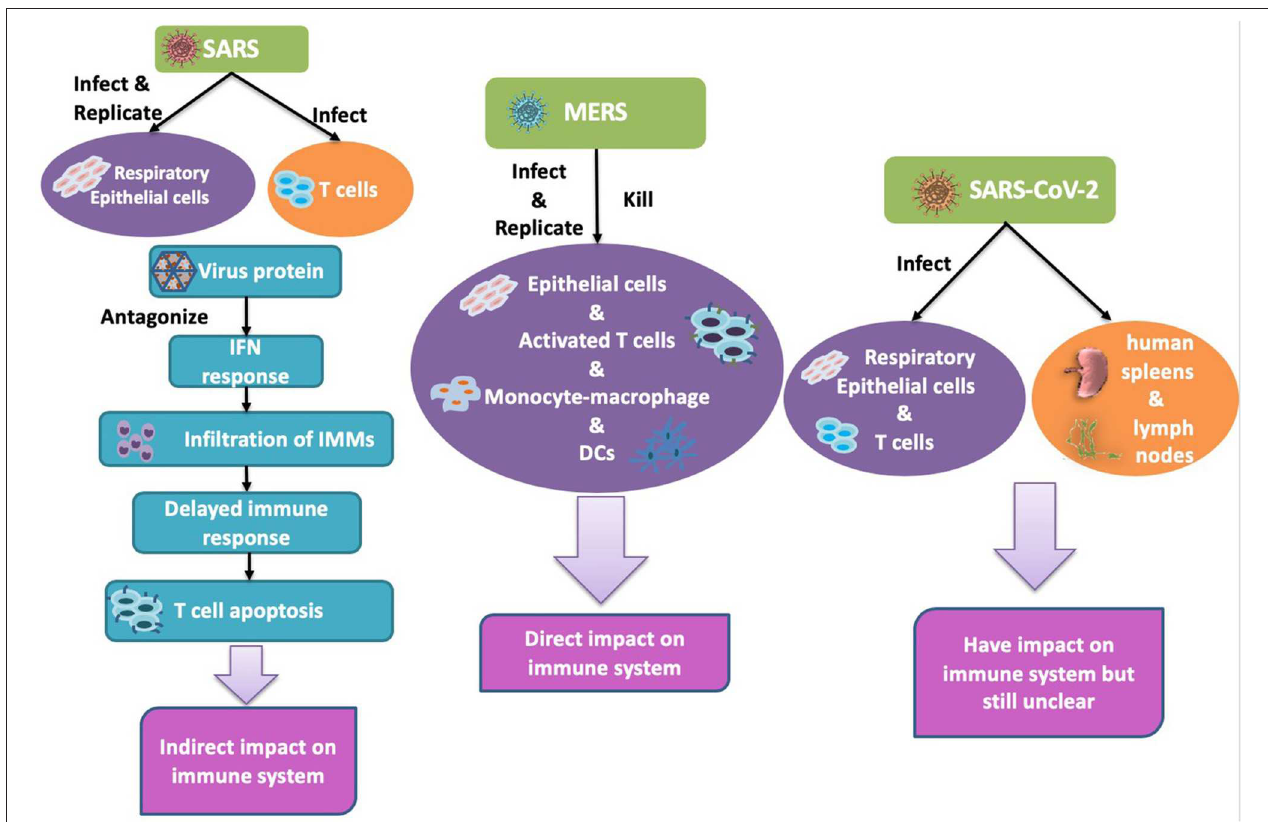
FIGURE 1 | Human coronavirus infects different types of cells. Left : SARS-CoV can infect alveolar epithelial cells and immune cells but can only replicate in epithelial cells. Middle : MERS-CoV infected and replicated in both alveolar epithelial cells and immune cells. Right : SARS-CoV2: infected lung and damaged lung and immune